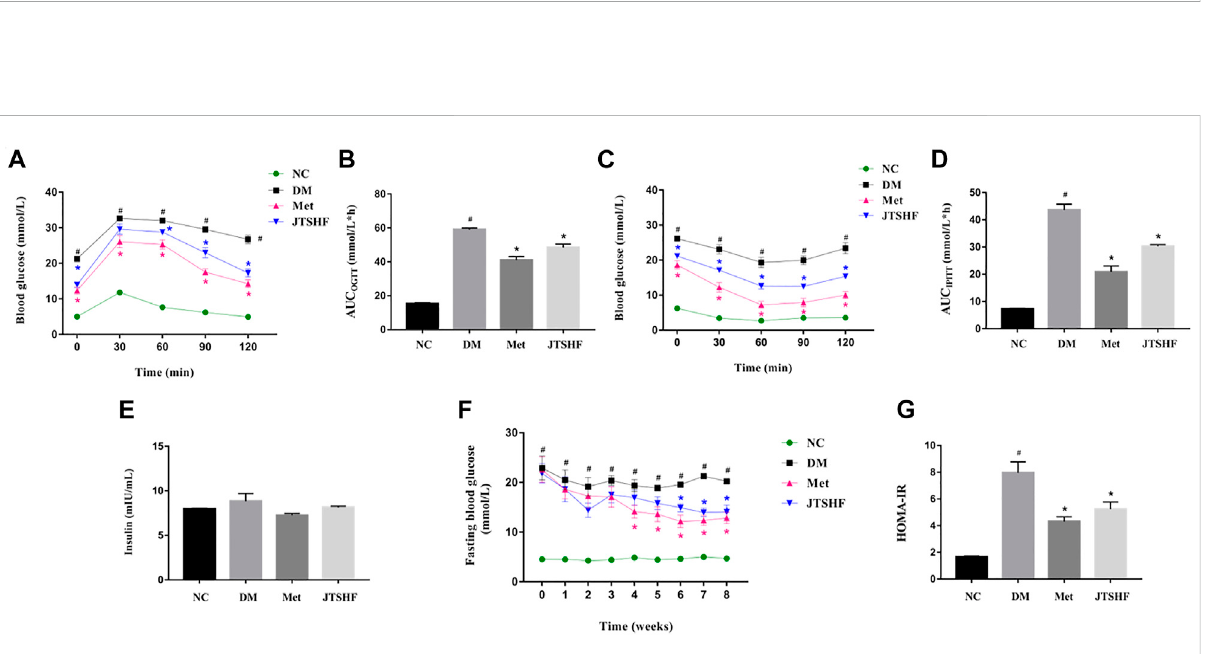
FIGURE 3 JTSHF improved glucose tolerance and enhanced insulin sensitivity in HFD-STZ induced diabetic mice. (A) OGTT and (B) area under the curve (AUC). (C) IPITT and (D) AUC. (E) fasting serum insulin levels and (F) fasting blood glucose levels, (G) Insulin resistance index of homeostasis model assessment (HOMA-IR). HOMA-IR = fasting insulin level (mU/L)×fasting glucose level (mmol/L)/22.5 (Zhang et al., 2018a). All values were expressed as mean ± SEM. # p < 0.05 versus NC group, * p < 0.05 versus DM group; n = 8 for each group in A – -F. Time in F means time of drug